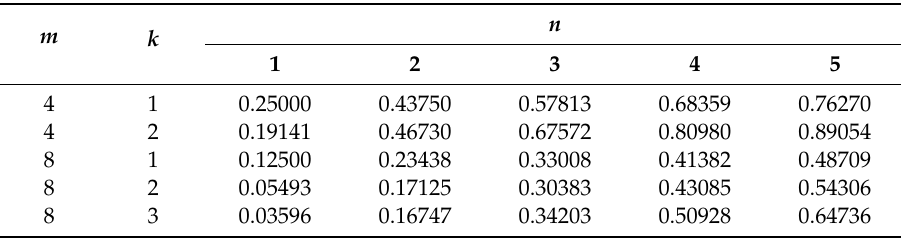
Table 3. False positive ratio for Bloom filters with size m , the number of hash functions k , and the degree of a prefix n